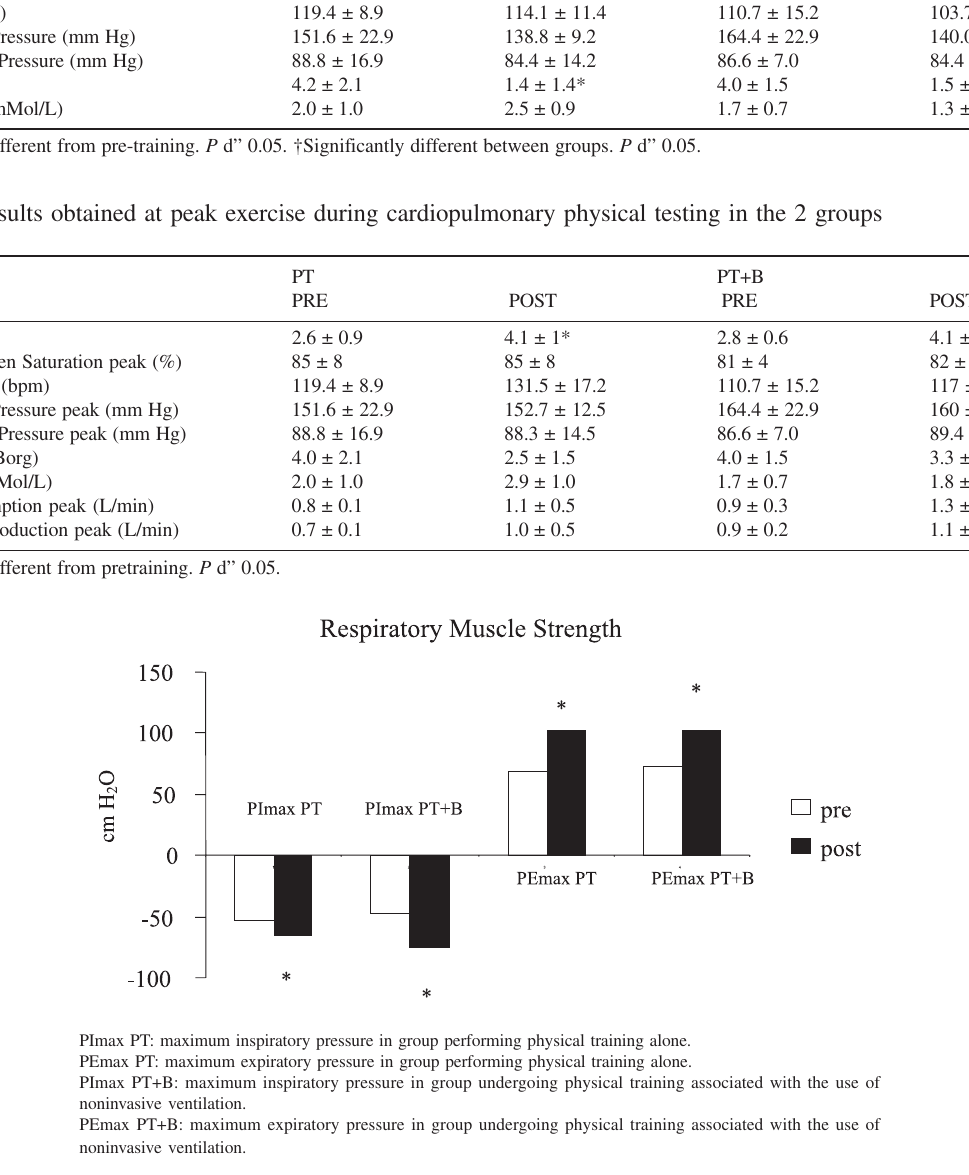
Figure 1 - Effect of physical training associated or not with the use of noninvasive ventilation on maximum expiratory and inspiratory